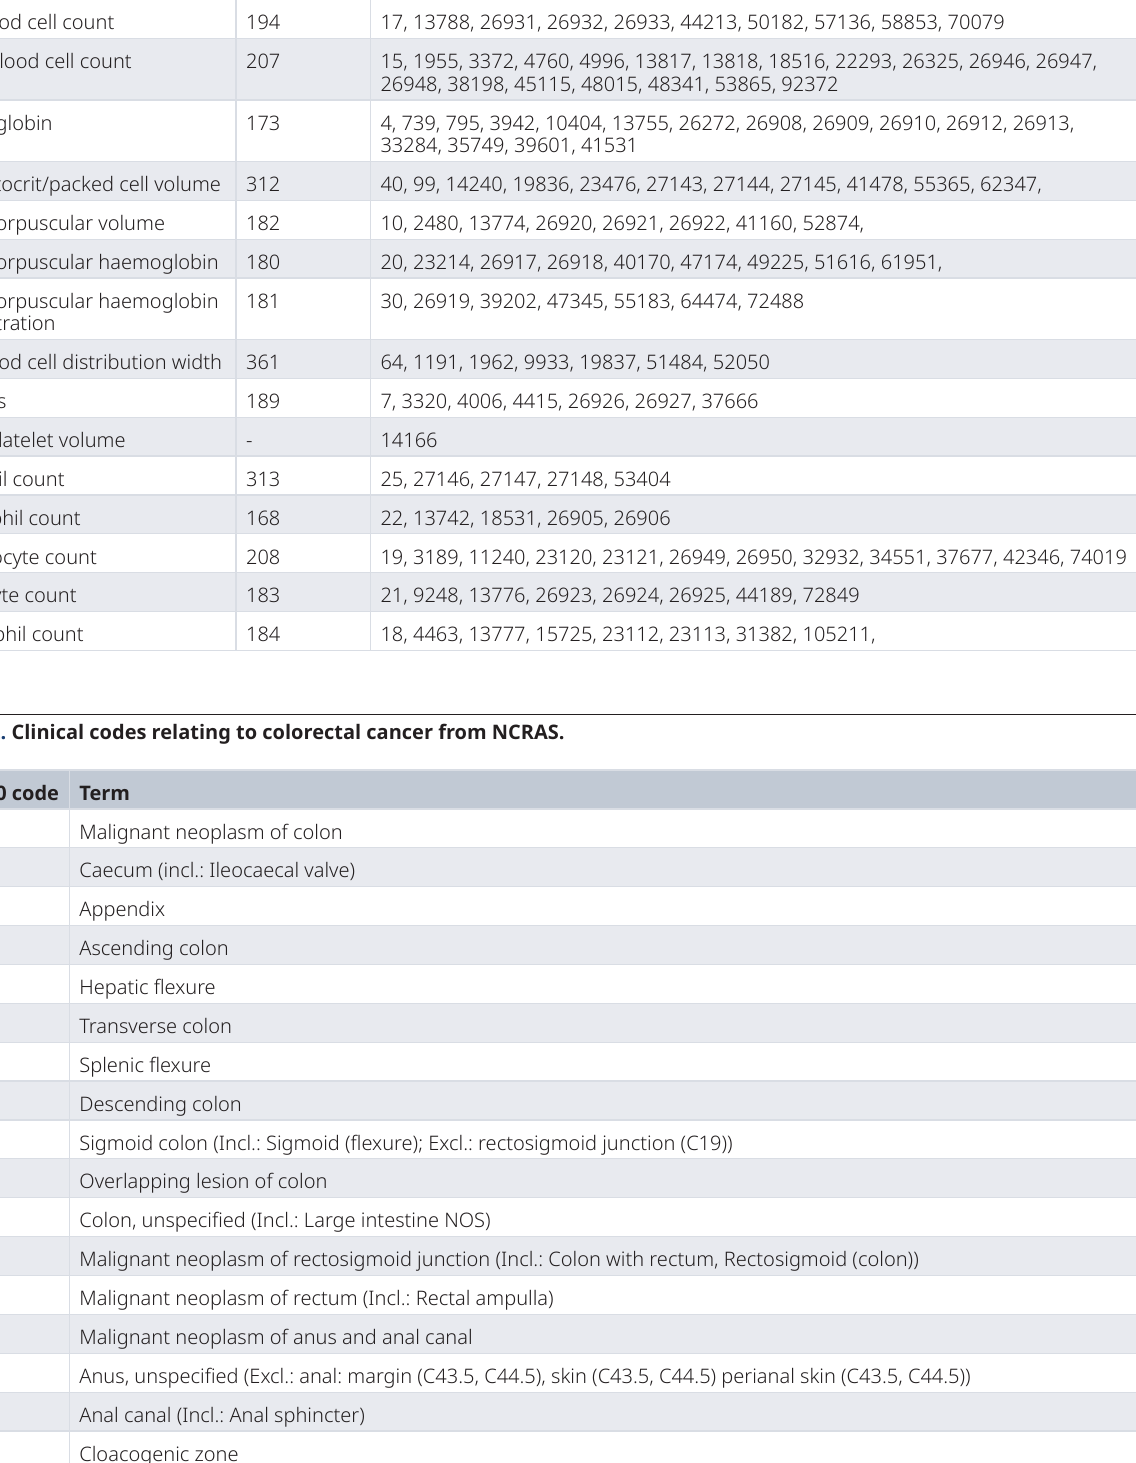
Table 1. Clinical codes relating to the full blood count from CPRD. FBC parameter